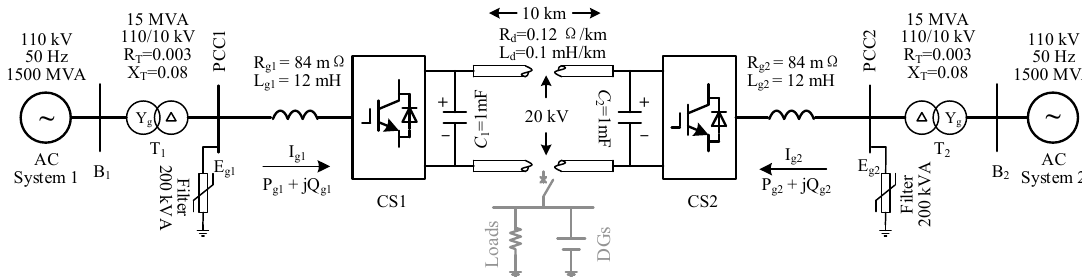
Figure 1. Single-line diagram of the two-terminal voltage source converter medium voltage direct current (VSC-MVDC) system studied.